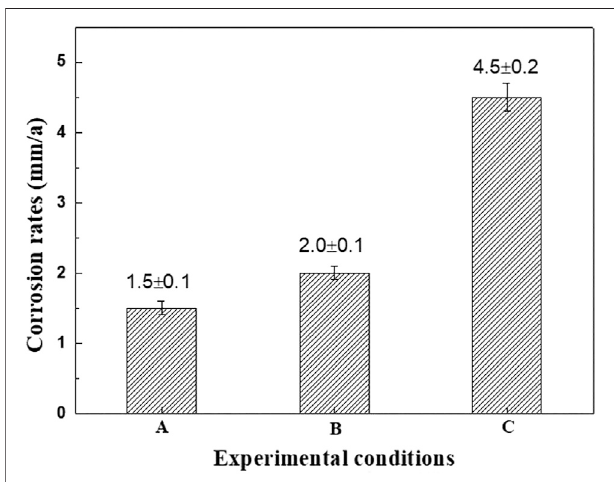
FIGURE 4 | Average corrosion rates of N80 at different experiment conditions A: CO 2 2.5MPa; B: O 2 0.5MPa; C: CO 2 2.5MPa, O 2 0.5MPa.